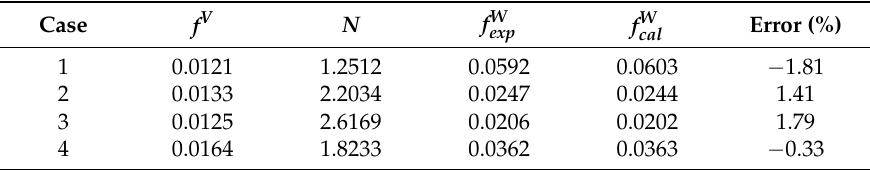
Table 1. Comparison of experimental and calculated results.